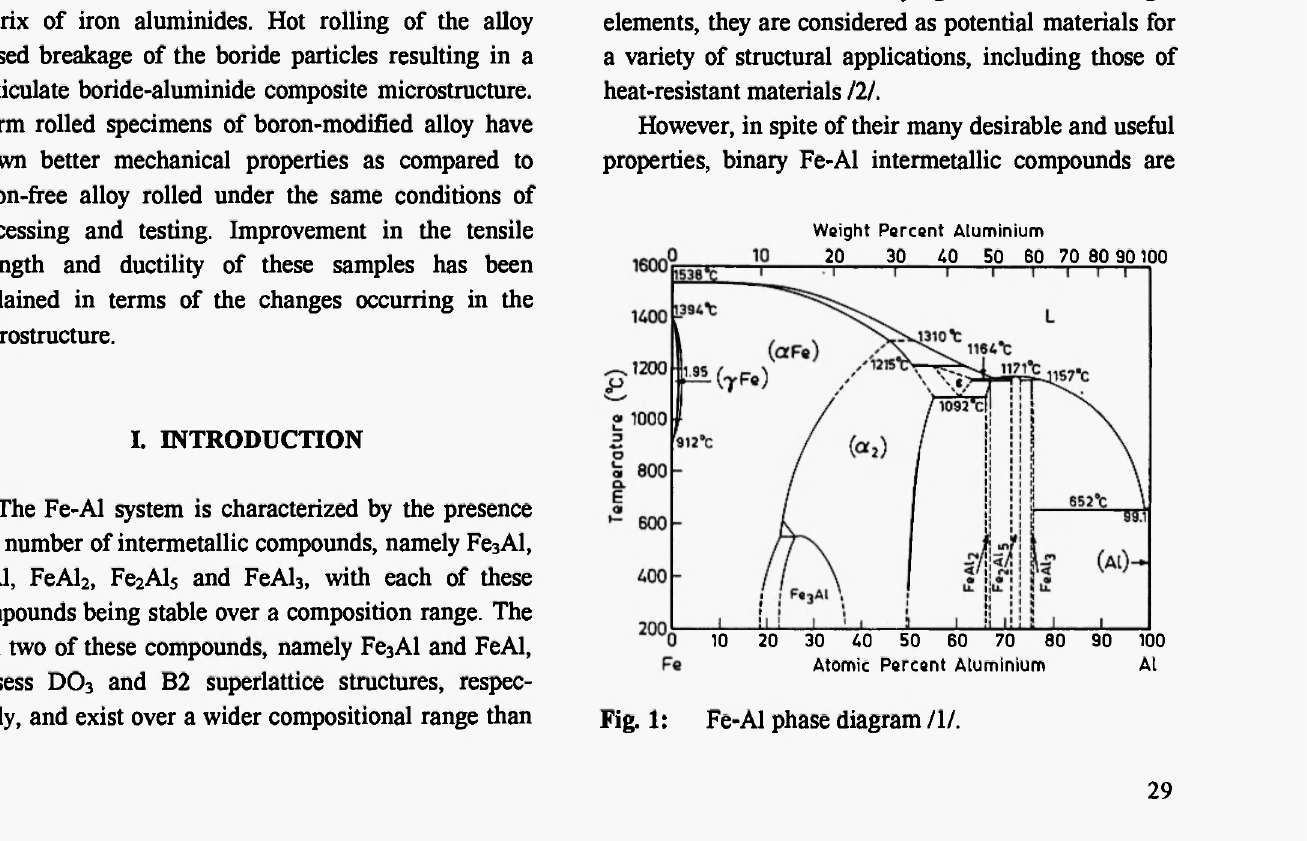
Fig. 1: Fe-Al phase diagram